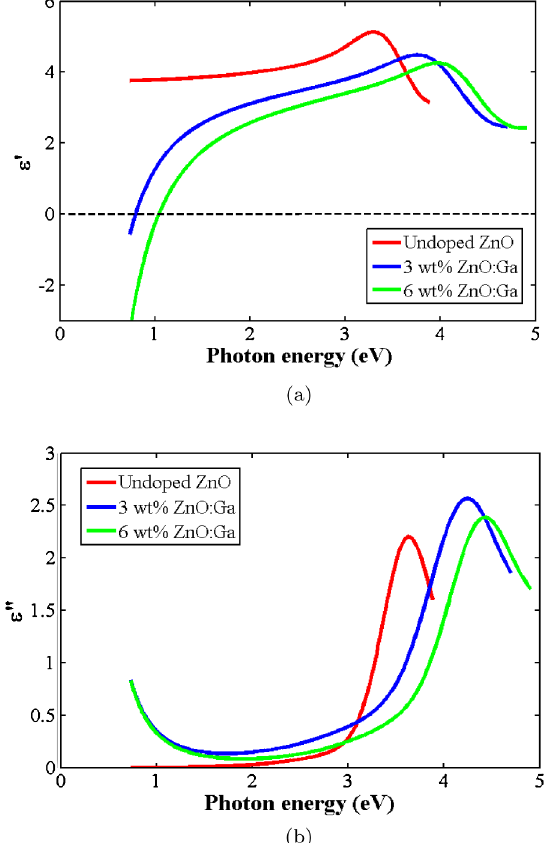
FIG. 3 (color online). Real and imaginary parts of the dielectric function spectra of w-ZnO and GZO thin films.